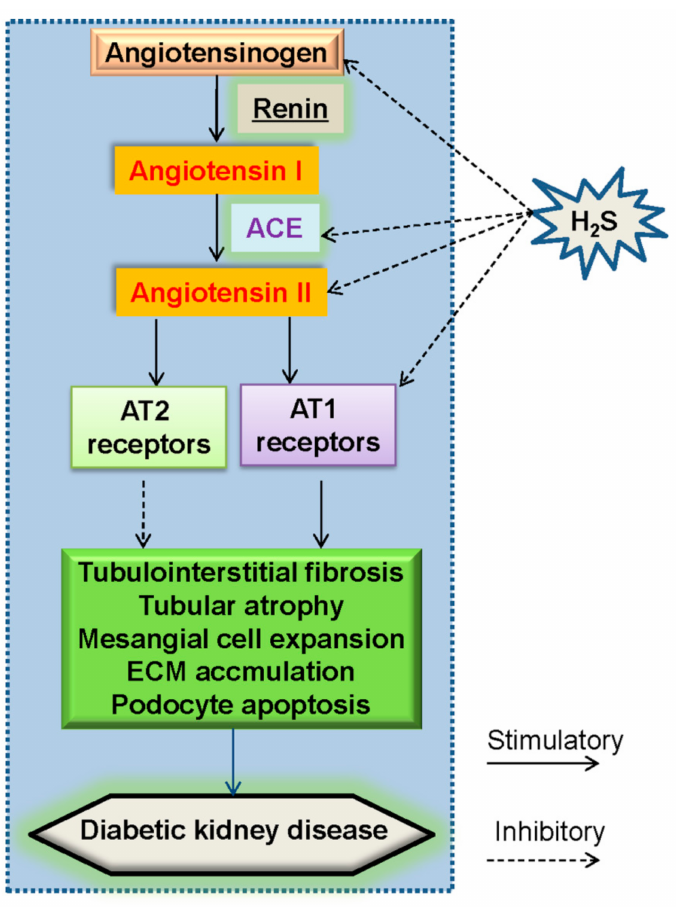
Figure 3. A proposed sketch showing the e ff ect of H 2 S on the renin-angiotensin-system (RAS). Angiotensinogen is cleaved by renin to produce angiotensin I, then angiotensin I is further converted to Ang II by ACE. The deleterious e ff ects of Ang II are mediated by AT1 receptors, whereas Ang II acts on AT2 receptors to function as a negative modulator of AT1 receptor actions. The activated RAS in diabetic kidney disease was ameliorated by H 2 S treatment via inhibition of angiotensinogen, ACE, Ang II and AT1 receptors. RAS, renin-angiotensin-system; ACE, angiotensin converting enzyme; Ang II, angiotensin